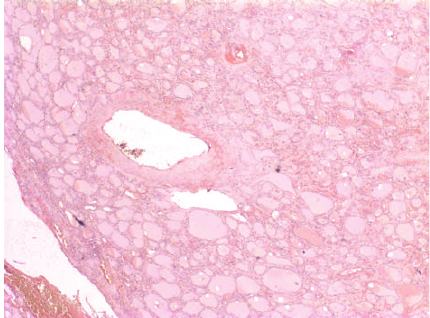
Figure 4: Red-colored amorphous substance accumulation com- patible with amyloid is seen in the interstitium within the nodule together with the arterial wall compressing parafollicular cells and thyroid epithelial cells (congo